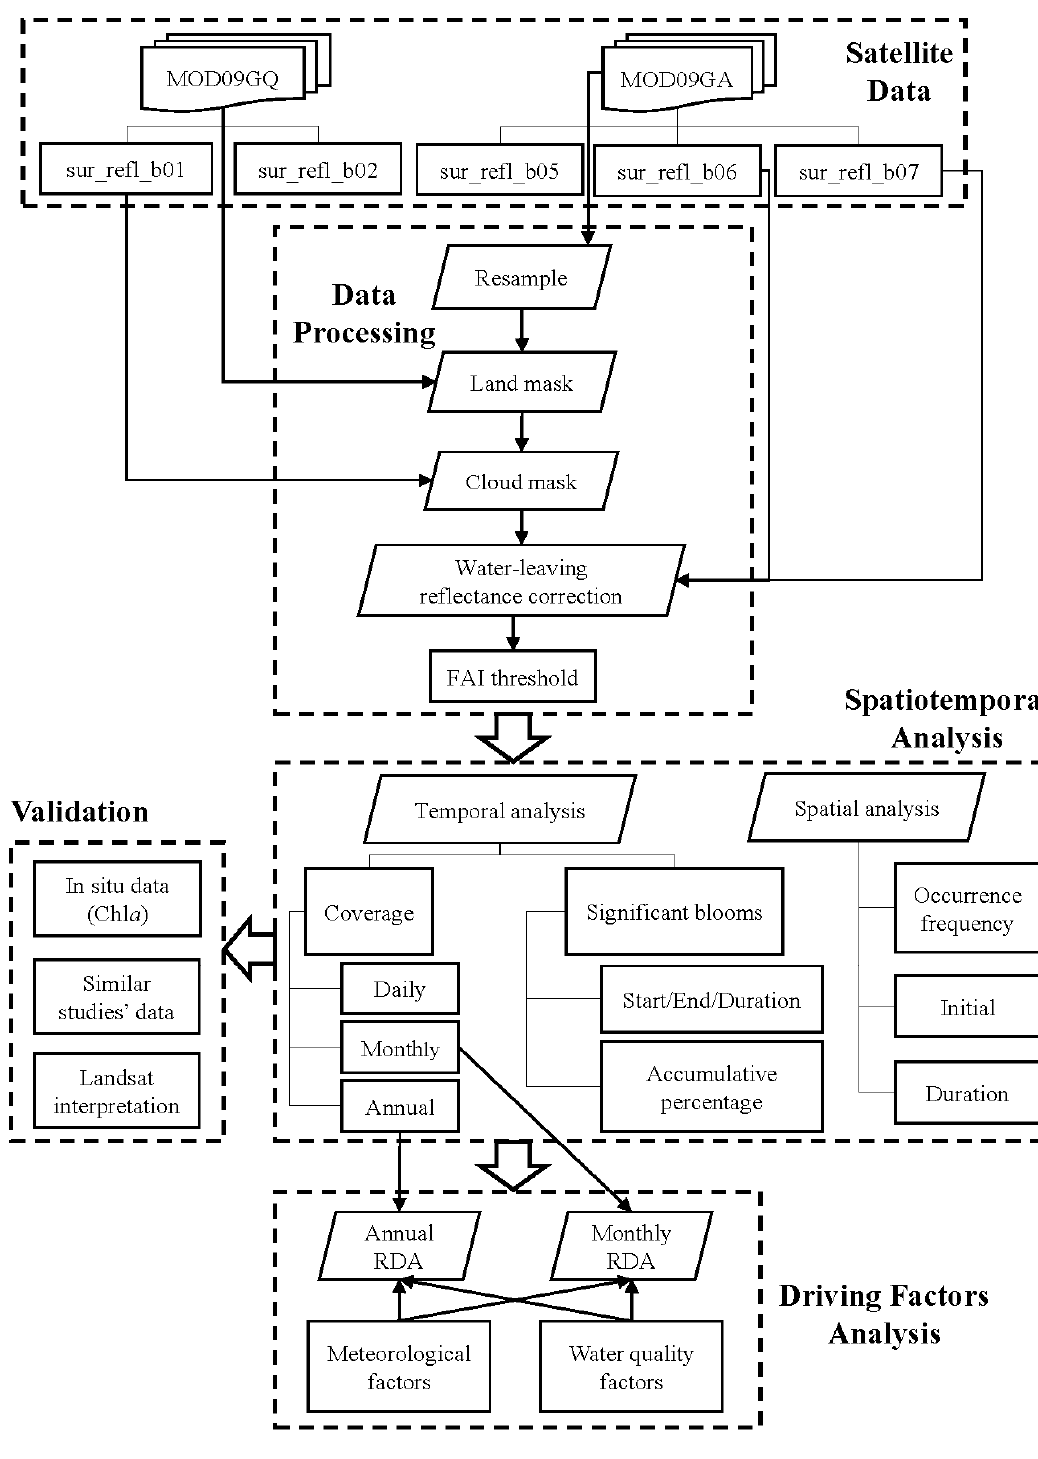
Figure 2. Workflow used in our study.